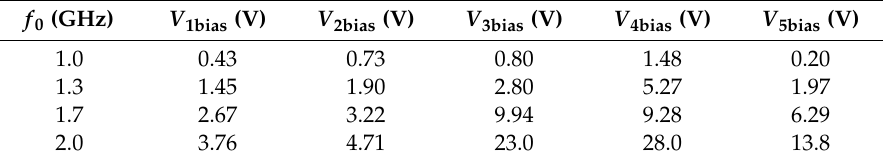
Figure 11. Measured results at 1.0, 1.3, 1.7, and 2.0 GHz. ( a ) | S 11 | and | S 23 |; ( b ) | S 22 | and | S 33 |; ( c ) | S 21 | and | S 31 |; ( d ) Amplitude imbalance; ( e ) Phase difference. Table 3. The values of V 1bias , V 2bias , V 3bias , V 4bias , and V 5bias for different frequencies.